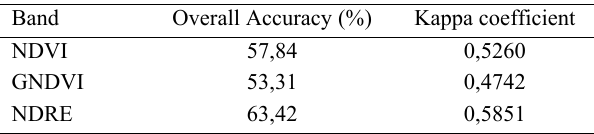
Table 4.Classification accuracy of single-band images